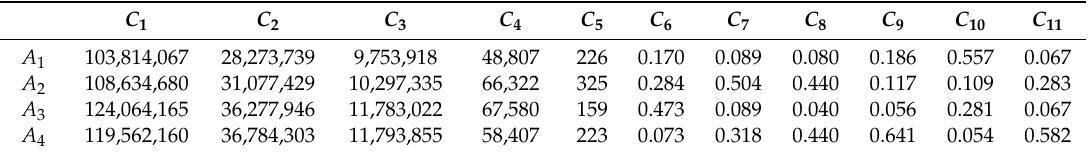
Table 7. Decision